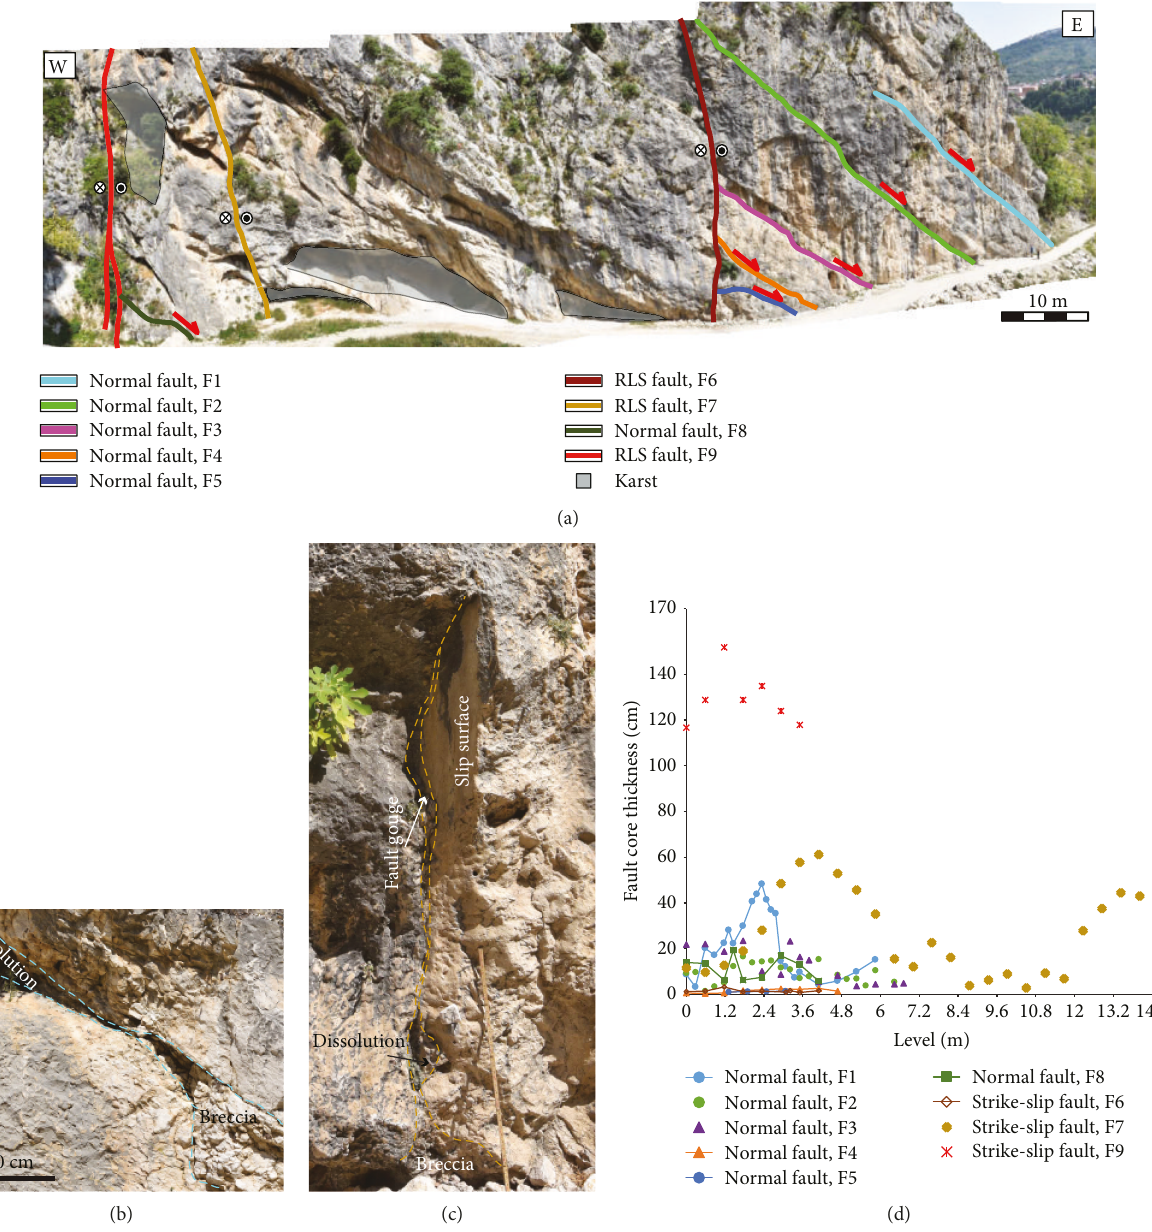
Figure 10: (a) Outcrop photo of the studied faults in scanline 3 in Vallone Santo Spirito (Maiella Mountain). The outcrop includes 6 normal and 3 strike-slip faults (right-lateral strike-slip (RLS)). (b) A closeup picture of the F1 internal core structure, indicating breccia and dissolution along the core. (c) A closeup picture of the F7 core, which shows breccia, dissolution features as well as fault gouge in the fault core. (d) Fault core thickness measurements performed both in the outcrop and on the photos along di ff erent heights of the